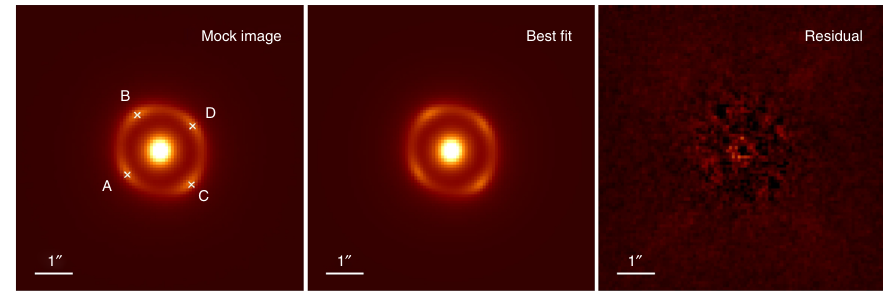
Fig. 3 Left: Simulation results based on HST, WFC3/F160w with image drizzled to 0.08 ′′ . Middle: Best- fi t image. Right: Residual map